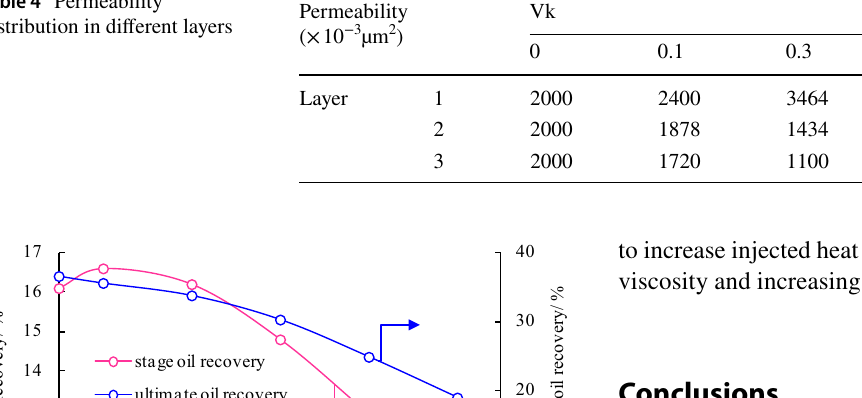
Table 4 Permeability distribution in different layers